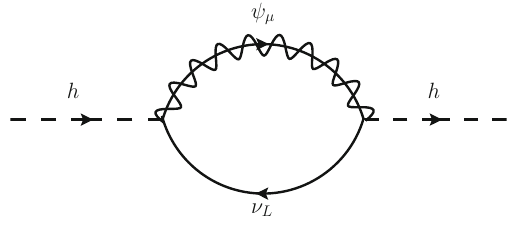
Fig. 8 The ψ μ − ν L loop that generates the logarithmic correction in (20) and the quartic correction in